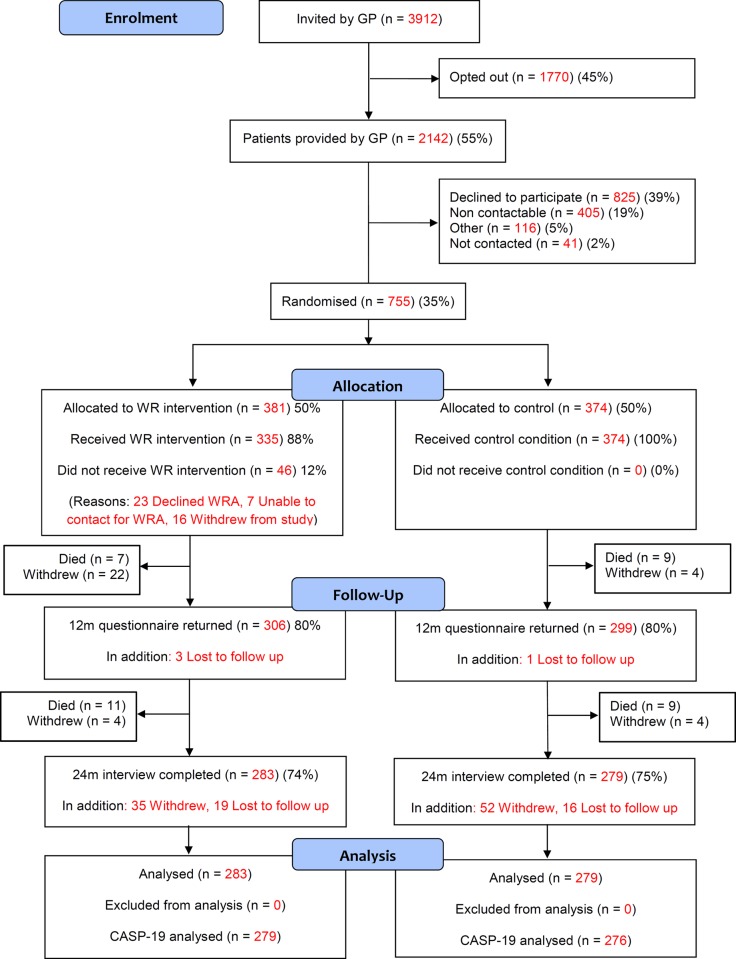
CONSORT [23] flow chart of participants in the RCT.